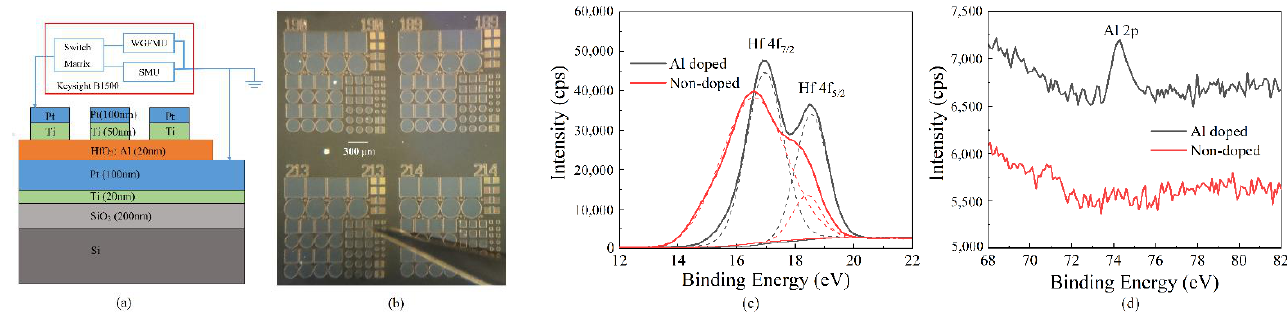
Figure 1. ( a ) A schematic diagram of the Ti/HfO 2 : Al/Pt resistive random-access memory (RRAM) device structure; the thickness of each layer does not represent the true proportion. ( b ) The microscopic optical image of the top electrode of the device. We prepared devices with different areas ranging from 10 μm × 10 μm to 300 μm × 300 μm. In our work, we only discussed the case of 100 μm × 100 μm. XPS spectra of ( c ) Hf 4f and ( d ) Al 2p in Al-doped and non-doped devices.